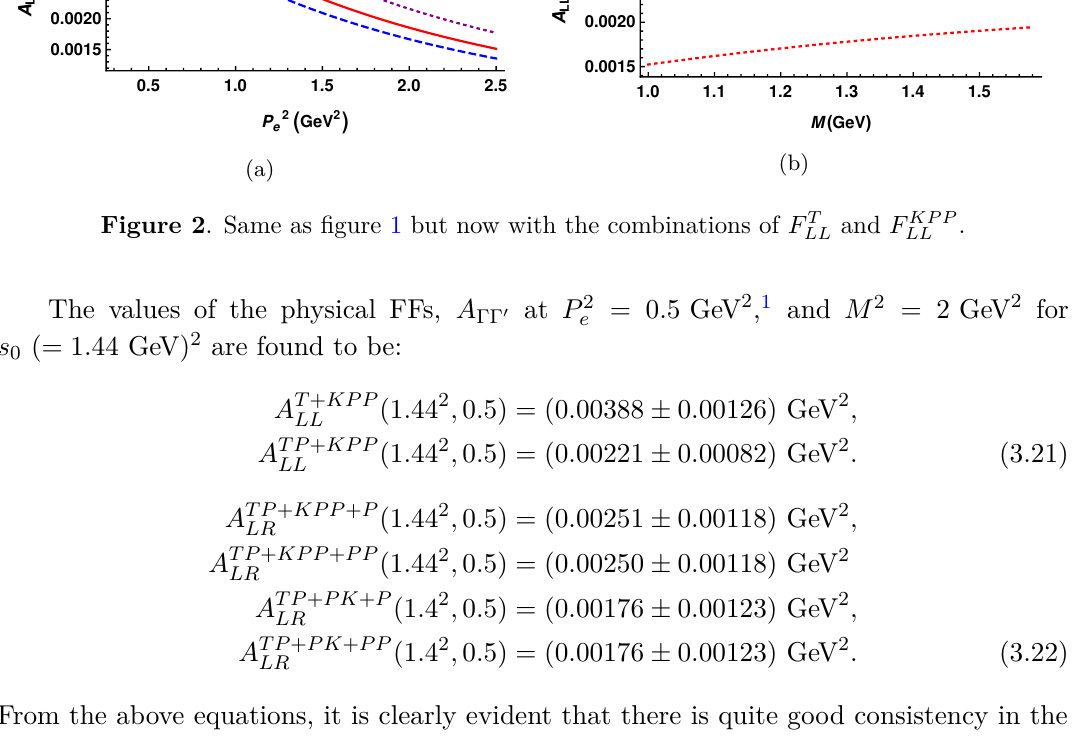
) is calculated from the combination of F TP e ( s ) vs P 2 is shown for three values of s 2 0 , P e e LL = (1 . 44 GeV ) 2 (red solid) and s = (1 . 5 GeV ) 2 (blue dashed) at 0 0 ( s ) vs M is shown for three values 2 0 , P e LL = 1 GeV 2 (red dashed) and P 2 = 2 GeV 2 (red dotted) at the e e = (1 . 44 GeV ) 2 . 0